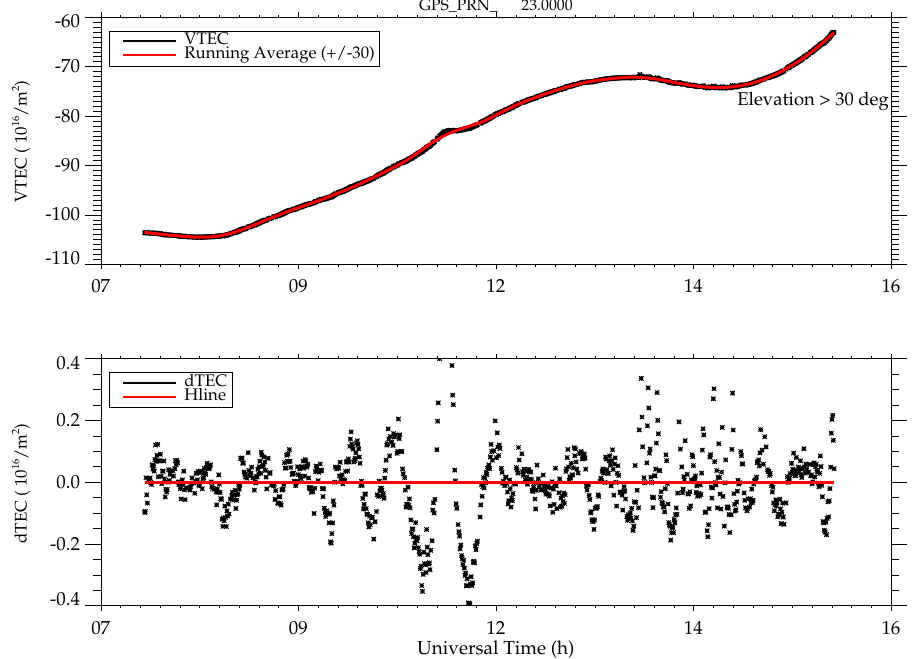
Figure 2. Vertical TEC ( upper panel ) with elevation greater than 30 ◦ and the corresponding dTEC ( lower panel